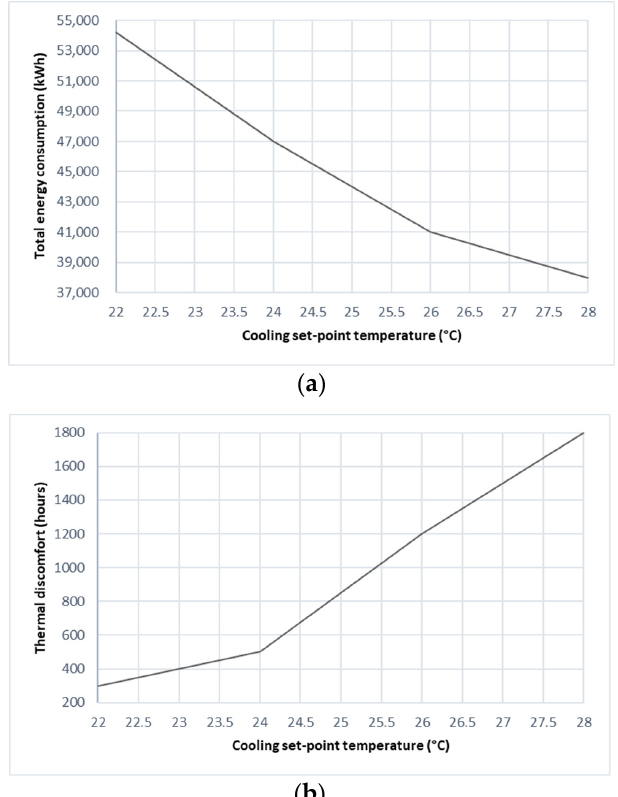
Figure 5. The effect of cooling set-point temperature on ( a ) energy consumption. ( b ) Students thermal discomfort hours